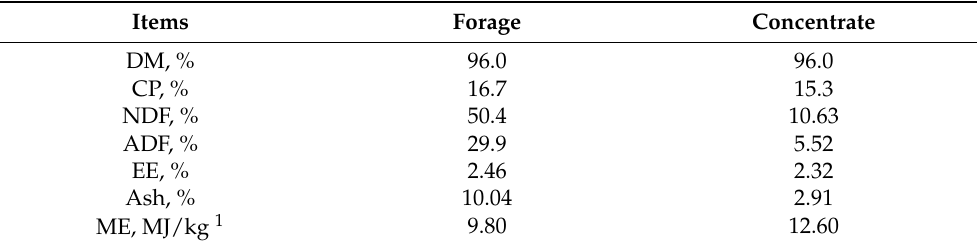
Table 1. Chemical composition of the natural pasture (forage) on the rangeland and the supplemen- tary concentrate feed (%, DM). Items Forage Concentrate DM, % 96.0 96.0 CP, % 16.7 15.3 NDF, % 50.4 ADF, % Ash,